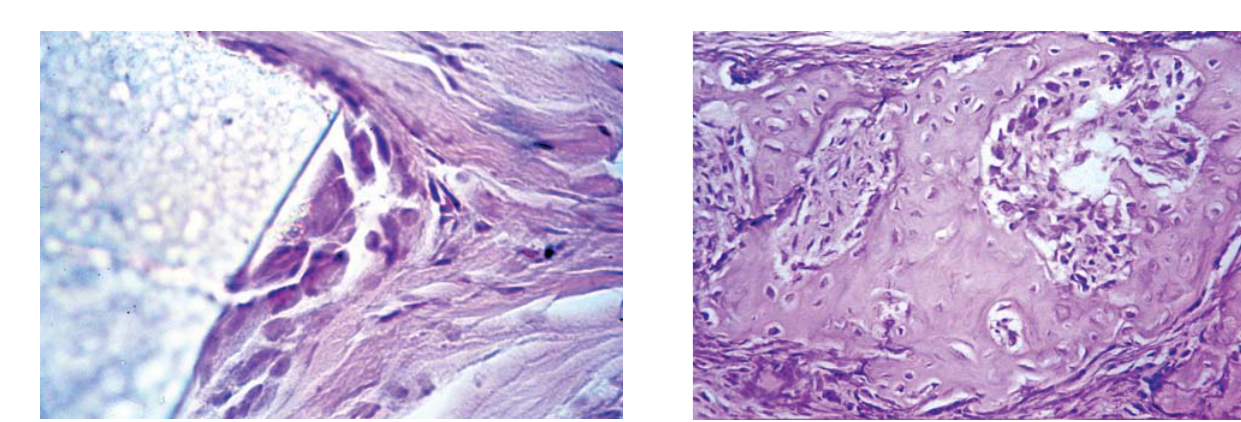
FIGURE 4- 45 days RC group. Coarse-fibered connective tissue formed. Cell differentiation into osteoblasts (H.E., original magnification, x200)